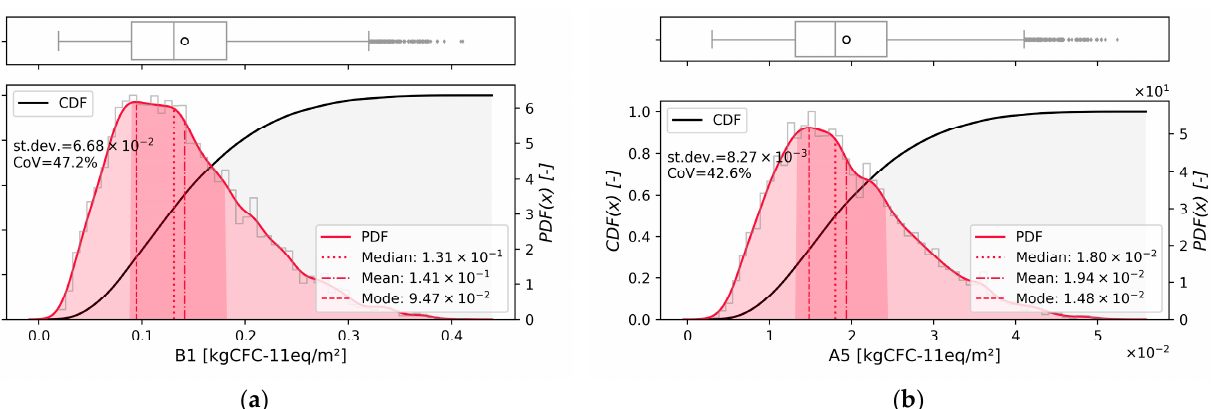
Figure 9. First-order (S 1 ) and total-order (S T ) sensitivity indexes for the expected annual impacts. Error bars represent the indexes’ con fi dence intervals (with a con fi dence level of 95%).